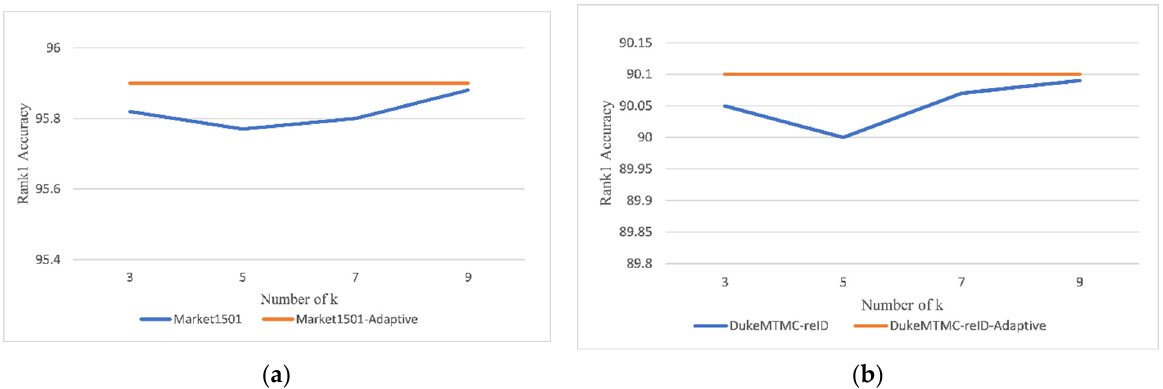
Figure 8. The effects of different k values on the model (( a ): Market1501 dataset, ( b ): DukeMTMC-reID). Also, we give the results when the kernel size k is selected adaptively.